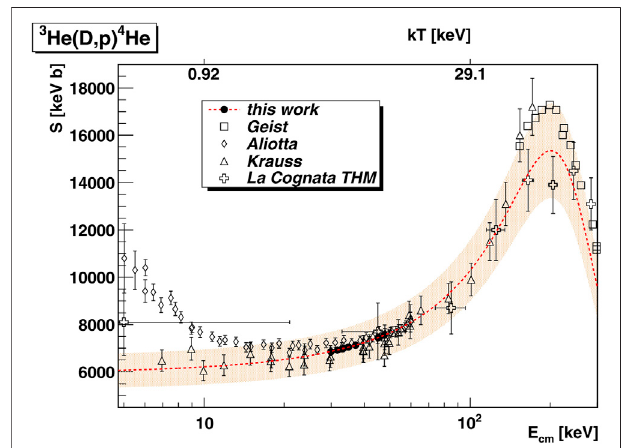
FIGURE3| Low-energy S-factorforthed ( 3 He,p) 4 He reaction,obtained by accelerator experiments [68, 70, 71] and high-power laser measurements ( “ thiswork ” from[72]).ThecrossesrepresentresultsobtainedwiththeTrojan- Horse Method (THM) [73]. The dashed curve shows the bare nuclear S-factor obtained from a fi t to the data at higher energies. The exponential enhancement in the S-factor at low energies, observed in the data by Aliotta et al. [70], is attributed to screening effects. Figure reprinted with permission from